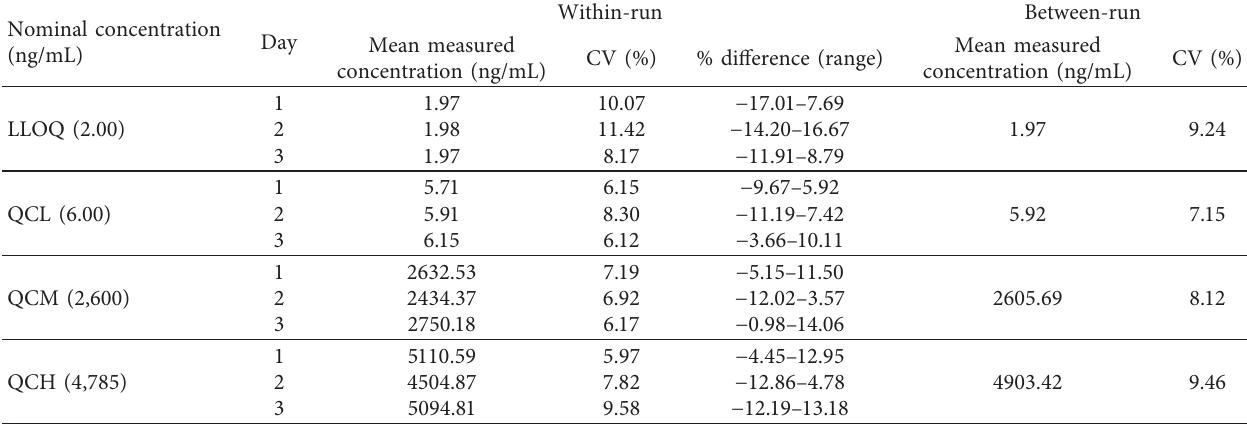
Table 3: Data of accuracy and precision, within-run, and between-run. Nominal concentration (ng/mL)